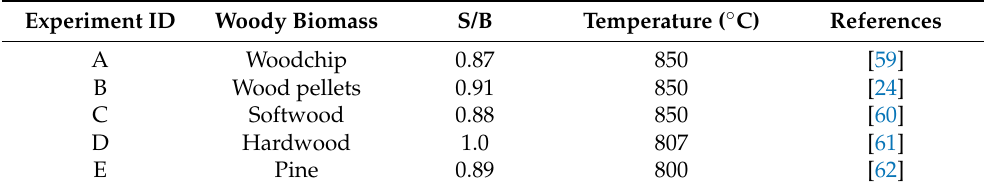
Figure 2. Experimental results of gas composition and LHV from steam gasification of some woody biomass in a dual fluidised-bed gasifier. Table 4. Operating conditions in the steam gasification of some woody biomass in a dual fluidised- bed